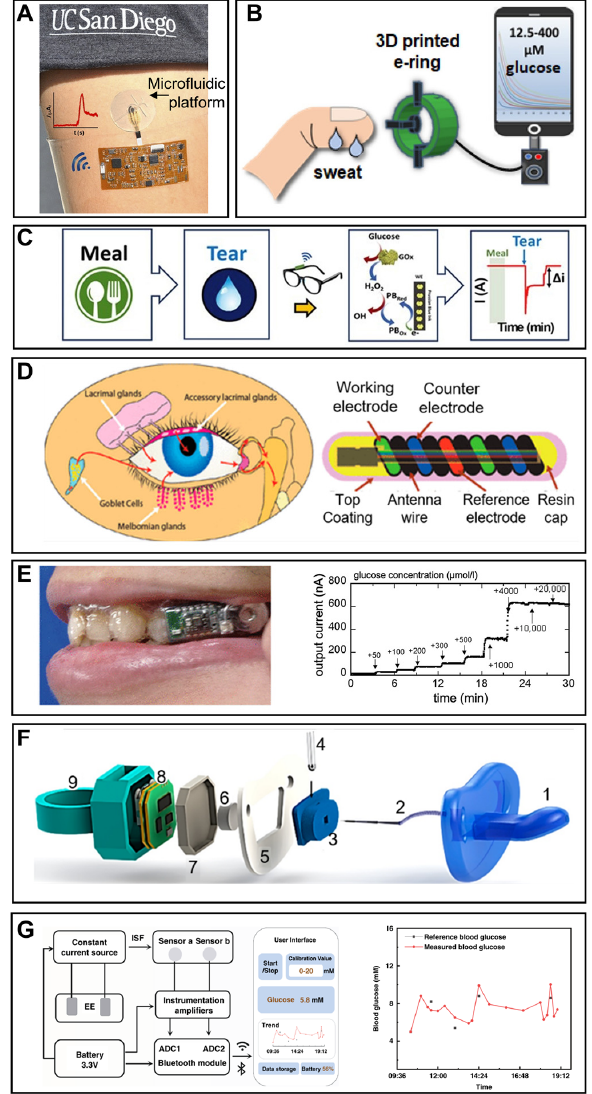
Figure 3. Smartphone-based wearable glucose monitoring. ( A ) In situ sweat glucose analysis based on the skin-mounted wireless electronics equipped with the microfluidic platform. Reprinted with permission from Ref. [90]. Copyright (2017) American Chemical Society. ( B ) Schematic illustration of the detection process of glucose concentration by the 3D-printed e-ring. Reprinted with permission from Ref. [92] Copyright (2020) American Chemical Society. ( C ) The on-body glucose sensing experiments of the eye glasses-based tears biosensor; the glucose levels were recorded for 3 h after a meal. Reprinted with permission from Ref. [100] Copyright (2019) Elsevier. ( D ) The design and structure schema of the NovioSense tear glucose sensor and the production of tear fluid. Adapted from Ref. [94] Copyright (2018) American Chemical Society. ( E ) Photograph of the mouthguard glucose sensor with wireless module and battery for salivary glucose monitoring and its responses to different glucose concentrations. Reprinted with permission from Ref. [97] Copyright (2020) American Chemical Society. ( F ) Scheme of the assembling of the pacifier and its matching medium: (1) nipple of the pacifier, (2) inlet for collecting saliva, (3) electrode chamber, (4) glucose electrode, (5) central piece, (6) outlet, (7) insulator pacifier cap, (8) integrated wireless potentiostat, and (9) back cap of the pacifier. Reprinted with permission from Ref. [40] Copyright (2019) American Chemical Society. ( G ) The systemic block diagram of a smartphone-based interstitial fluid glucose monitoring watch and blood glucose variation curve of a volunteer measured by this system. Adapted from Ref. [99] Copyright (2022) Springer Nature.